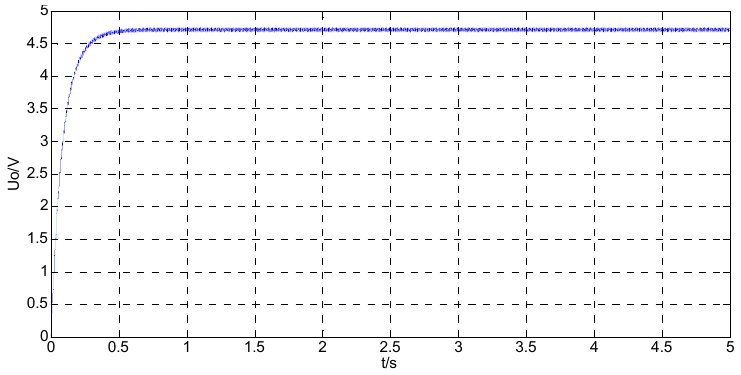
Figure 9. Multisim simulation of charging voltage.